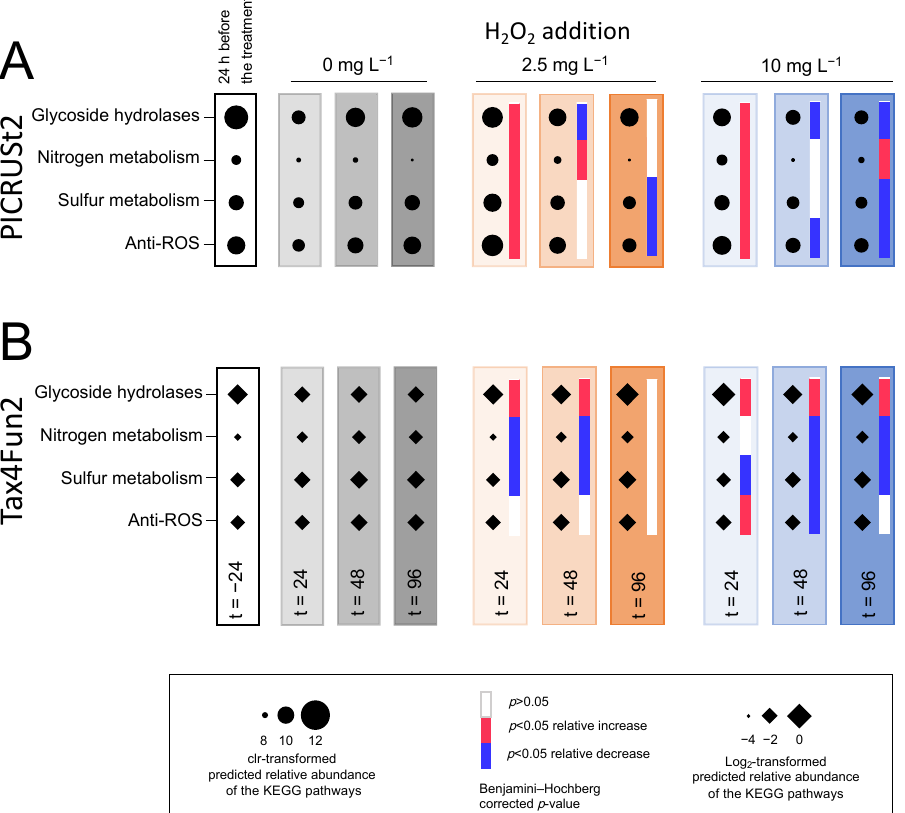
Figure 10. Functional prediction of the microbial community during the incubation experiments in August. The graphs show relative abundances of the selected KEGG orthologs or pathways for glycoside hydrolases, nitrogen and sulfur metabolism and anti-ROS enzymes during the incubation experiments in August as predicted by ( A ) PICRUSt2 and ( B ) Tax4Fun2. The first column presents relative abundances of the KEGG pathways in the lake prior to the incubation experiments (t = − 24 h, with n = seven biological replicates). The other columns present relative abundances in the incubation experiments at the three subsequent time points (t = 24, 48 and 96 h, with n = four biological replicates per time point). Gray columns represent the control incubations (0 mg L − 1 H 2 O 2 ), orange columns— the 2.5 mg L − 1 H 2 O 2 -treated incubations, blue columns—the 10 mg L − 1 H 2 O 2 -treated incubations. The color intensities of the columns represent different time points. Relative abundances are shown as ( A ) clr-transformed counts for PICRUSt2 and ( B ) log 2 -transformed percentages for Tax4Fun2. Significant differences in relative abundances at the same time point between the treated and control incubations were tested using ( A ) ALDEx2 and ( B ) the Wilcoxon test (see the Materials and Section 2 for details). Significant increases compared to the control are shown in red, significant decreases—in blue, in the heat map next to each time point. White fields in the heat map indicate that the relative abundances were not significantly different between the treated and control